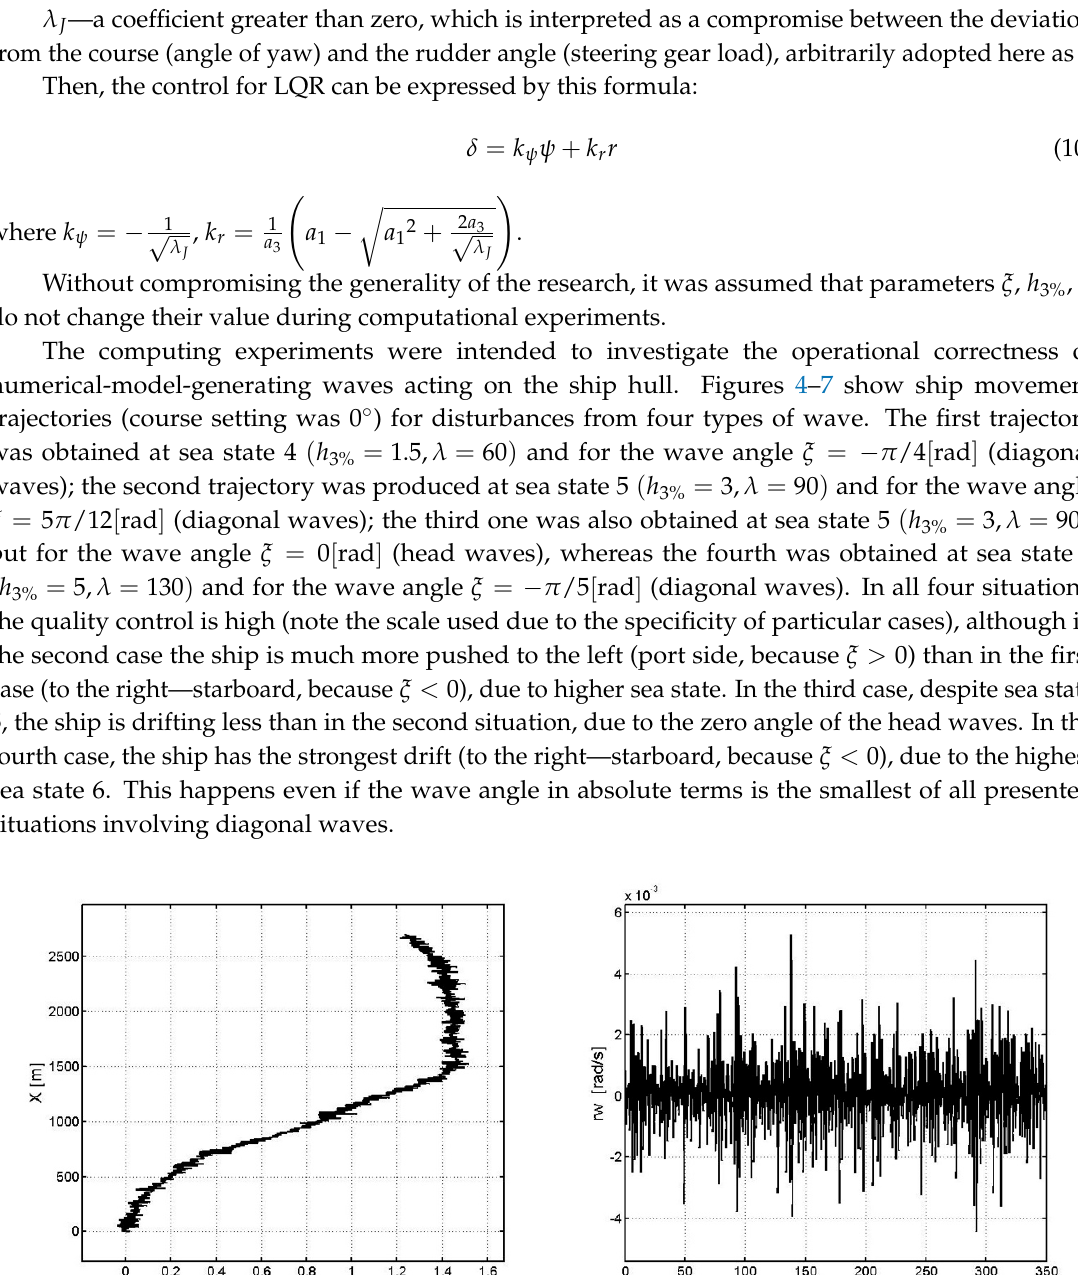
Figure 5. The trajectory of ship movement and signal of angular speed disturbance r w for sea state 5 and the wave angle 5 π /12. Figure 6. The trajectory of ship movement and signal of angular speed disturbance r w for sea state 5 and the wave angle 0.